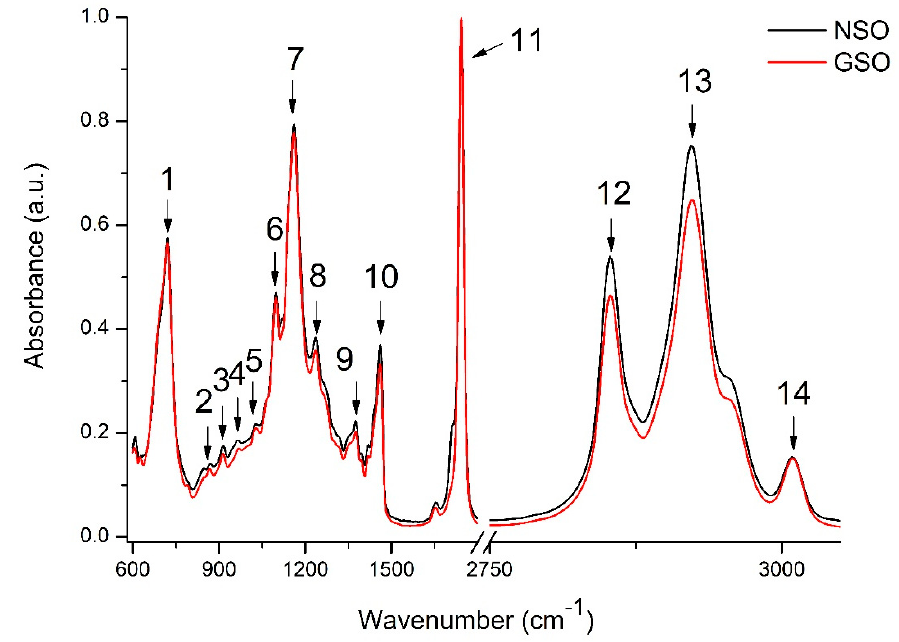
Figure 1. NSO and GSO general FTIR spectra (600–3100 cm − 1 ). For peak assignment, see Table 2.